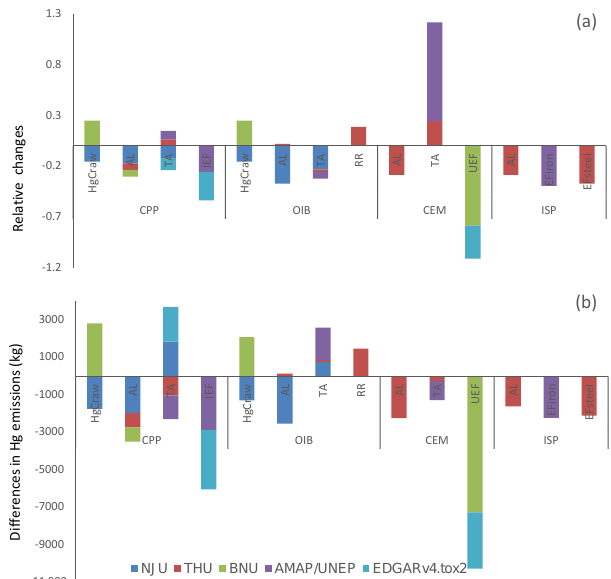
Figure 2. Sensitivity analysis of selected parameters in Hg emission estimation for Category 1 sources. (a) Relative changes in param- eters, calculated using Eq. (6), and (b) changes in emissions when parameters in the provincial inventory were replaced with those in other inventories, calculated using Eq. (7). HgC raw : Hg content in raw coal; AL: activity levels as raw coal consumption by CPP and OIB, limestone used by CEM, and crude steel produced in ISPs; TA: total abatement rate of APCDs; RR: Hg release rate for combus- tion; IEF: input emission factors (before control of APCDs); UEF: uniform emission factor (without consideration of different APCD types); EF iron and EF steel : emission factors of pig iron and steel production,